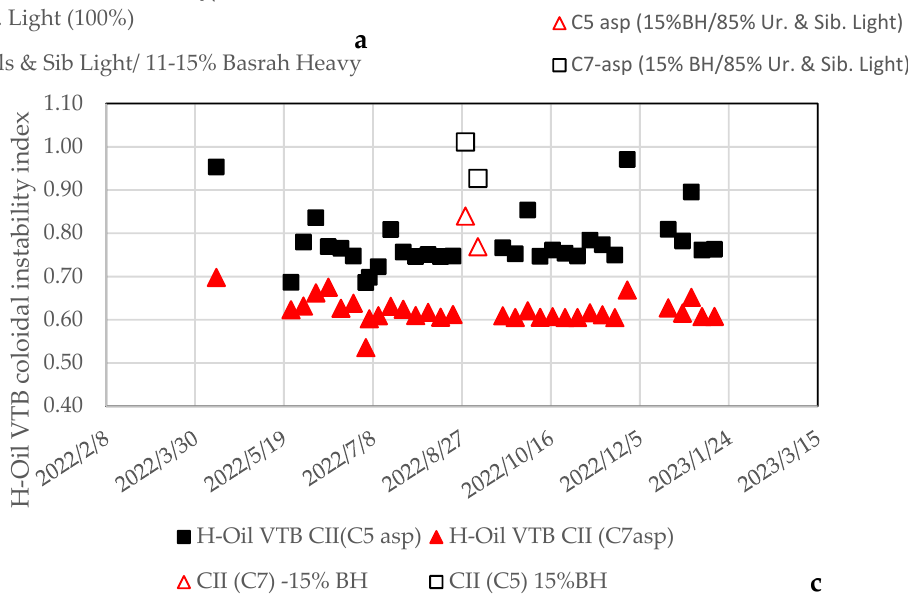
Figure 12. Variation of saturate ( a ), and asphaltene ( b ) contents, and colloidal instability index ( c ) of the hydrocracked vacuum residue for the investigated period.